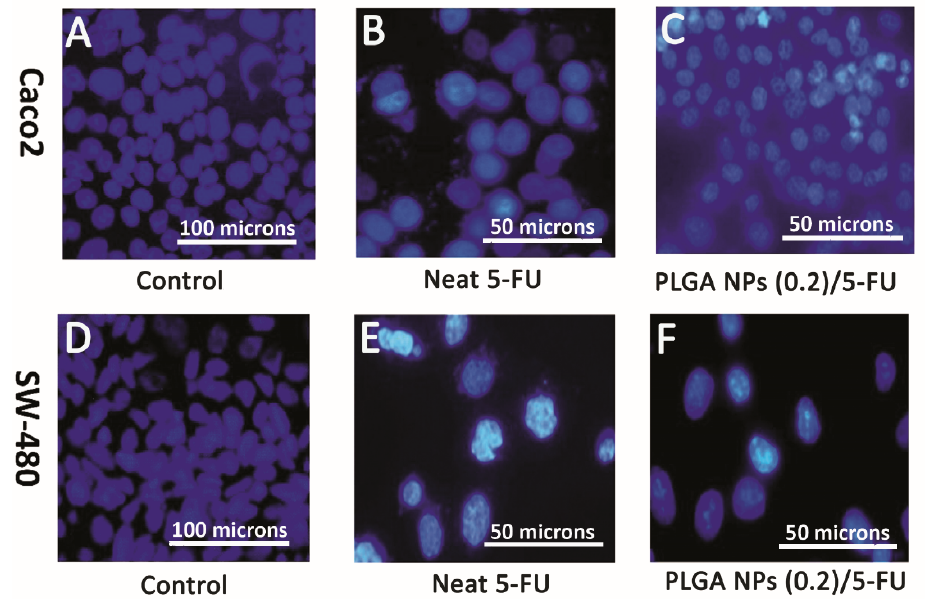
Figure 8. Representative fluorescence micrographs (DAPI, blue) showing morphologically death of Caco2 and SW-480 cell lines after DAPI staining: ( A , D ) control [magnification 200 × ], ( B , E ) neat 5-FU and ( C , F ) PLGA NPs (0.2) / 5-FU [magnification 400 × ].